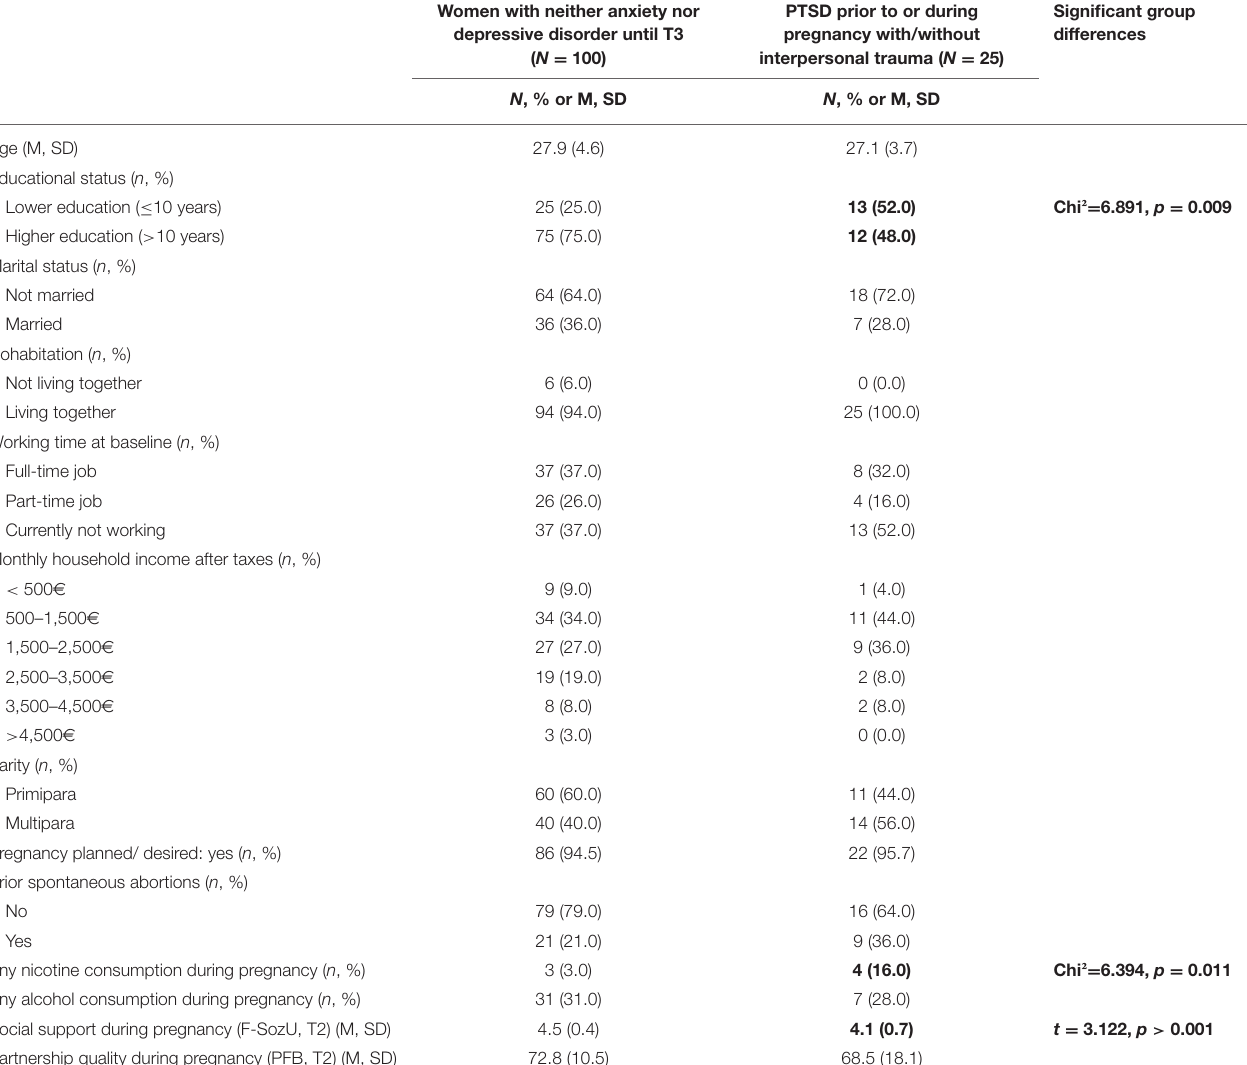
TABLE 1 | Sociodemographic and gynecological characteristics of women with any PTSD until T3 (with/without interpersonal trauma) ( N = 25) as compared to women with neither anxiety nor depressive disorder until T3 ( N = 100).